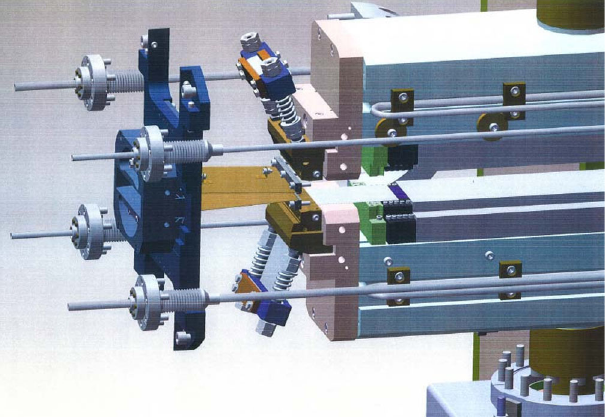
(lower).FIG. 1. Layout of the ID tapered transition without vacuum